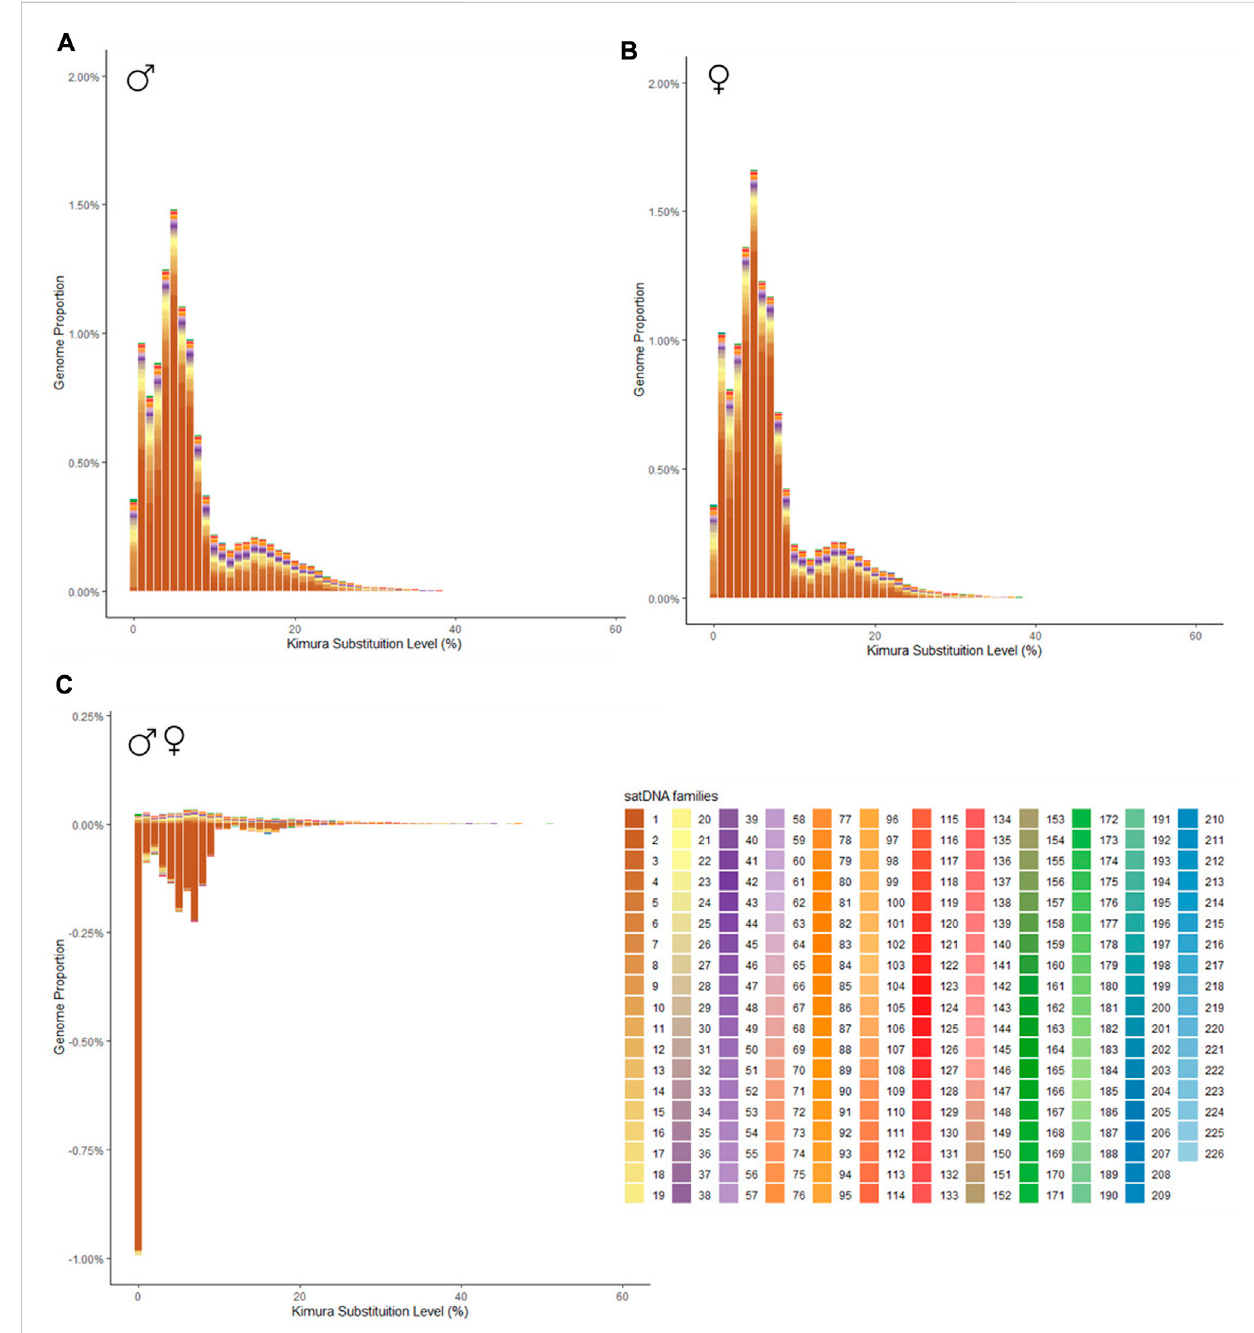
FIGURE 1 Repeat landscape (abundance vs divergence) for satDNAs identi fi ed in Proceratophrys boiei . (A) male genome; (B) female genome; (C) Subtractive repetitive landscape. The graphs show, for each color-coded element, the sequence divergence according to Kimura distance ( x -axis) in relation to their copies in the genome ( y -axis). Copies clustered to the left (lower divergence) potentially correspond to recent copies occurring in the genome. In the subtractive graphic, abundance values show the difference between the male minus the female genomes, thus, positive values indicate overabundance in the male, and negative values indicate overabundance in the female